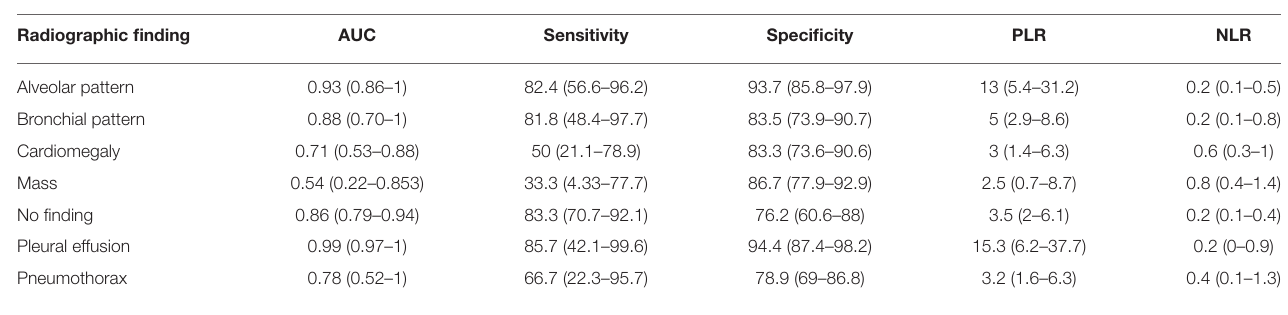
TABLE 2 | Performance of InceptionV3 in the test